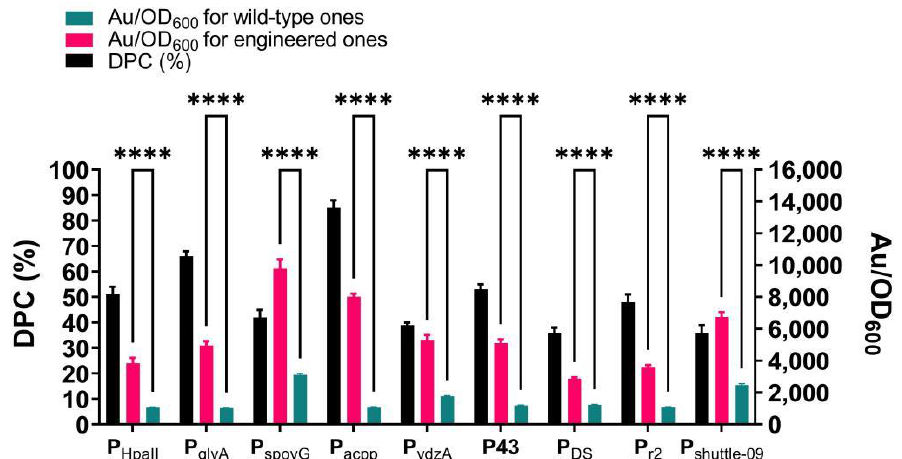
Figure 7. Characterization of DPC and expression strength of different promoters inserted with UP5-2P. Au—Arbitrary unit. Au is Arbitrary unit. Results are expressed as mean of replicates; columns with **** represent statistically significant differences between groups at p < 0.0001.